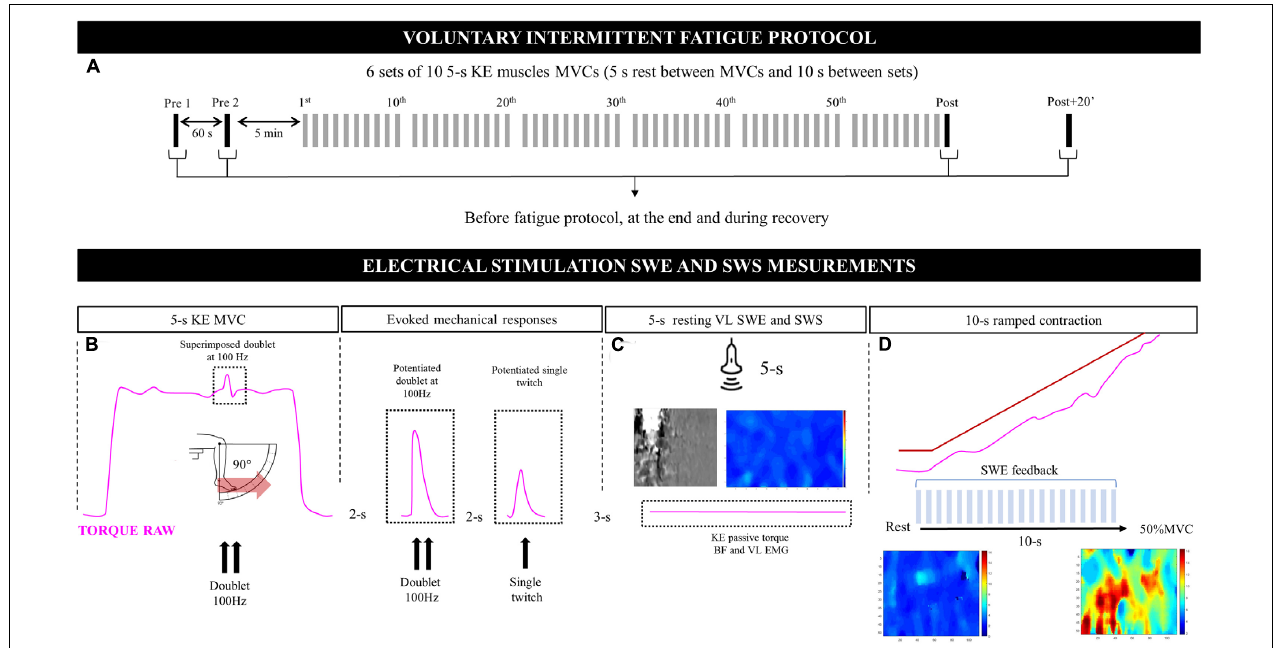
FIGURE 1 | Design of the voluntary intermittent fatigue protocol (top; A ), consisting of a series of voluntary force, electrical stimulation, and muscle viscoelasticity measurements performed before and after the fatigue protocol (bottom; B – D ). KE, knee extensors; MVC, maximal voluntary contraction; SWE, shear-wave elastography; EMG, surface electromyography; VL, vastus lateralis ; BF, biceps femoris ; SWS, shear-wave